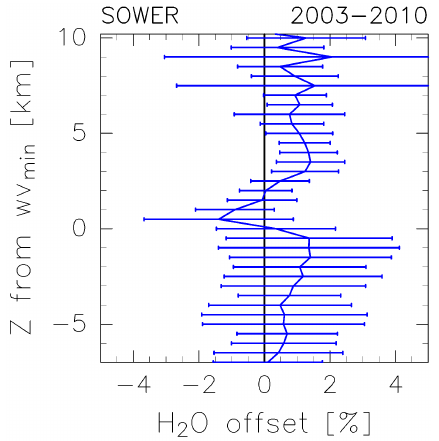
Figure 9. As for Fig. 8 but for the biases based on relative altitude with reference to that of the water vapor minimum near the